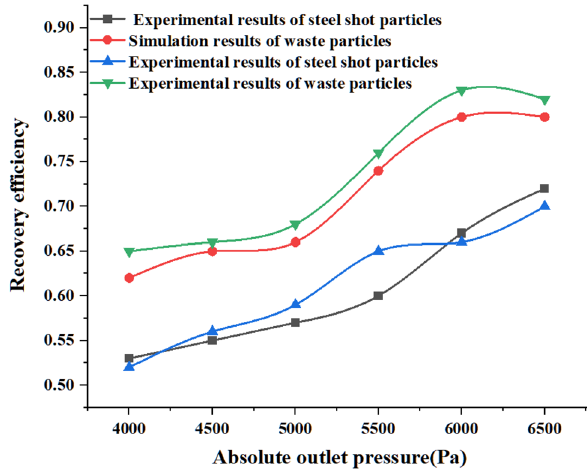
Figure 16. Comparison of recovery efficiency test and simulation.